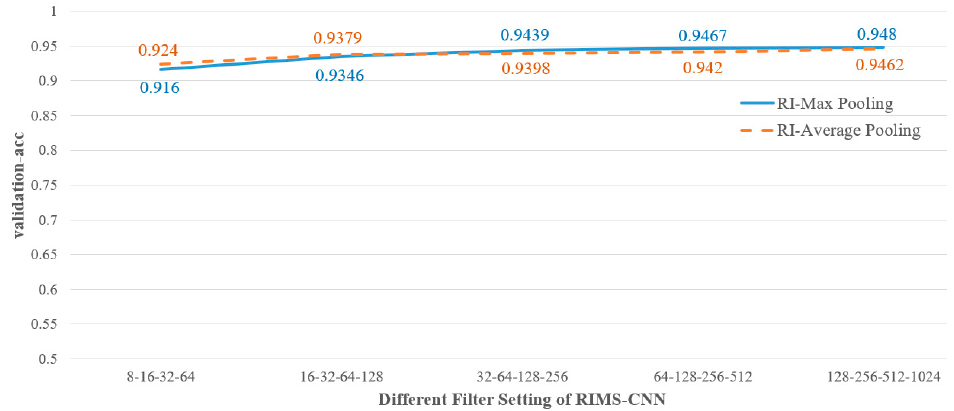
Figure 17. Comparing RI-max pooling with RI-average pooling on the fixed-angle rotated FASHION-MNIST.